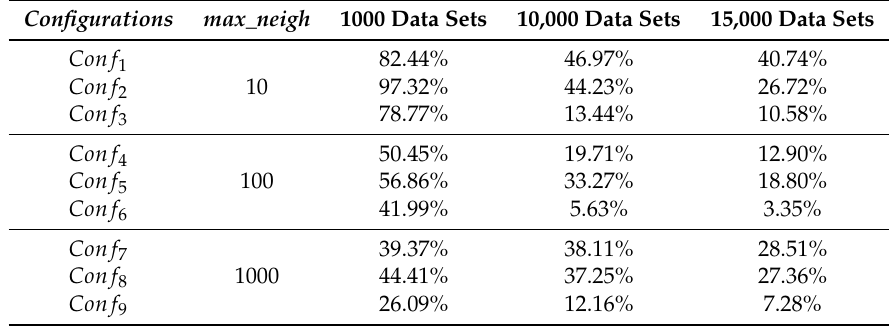
Table 11. Fraction of average execution times for version Spark V2 of the algorithm, in comparison with basic Spark implementation executed on environment Env 3